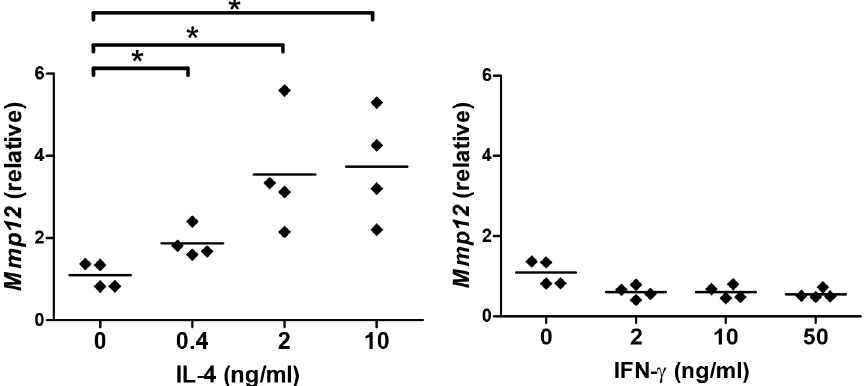
Fig 5. IL-4 enhances Mmp12 expression in macrophages. Bone marrow derived macrophages were stimulated with different concentrations of IL-4 or IFN- γ and the expression of Mmp12 was measured by quantitative RT-PCR. Summarized results of 4 independent experiments are shown. Each symbol represents an individual experiment and the horizontal lines represent the means. * , p < 0.05 using Kruskal-Wallis one- way ANOVA followed Dunn's post